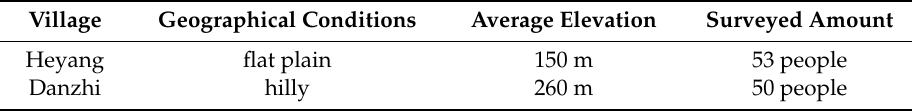
Table 1. Village conditions and survey population.